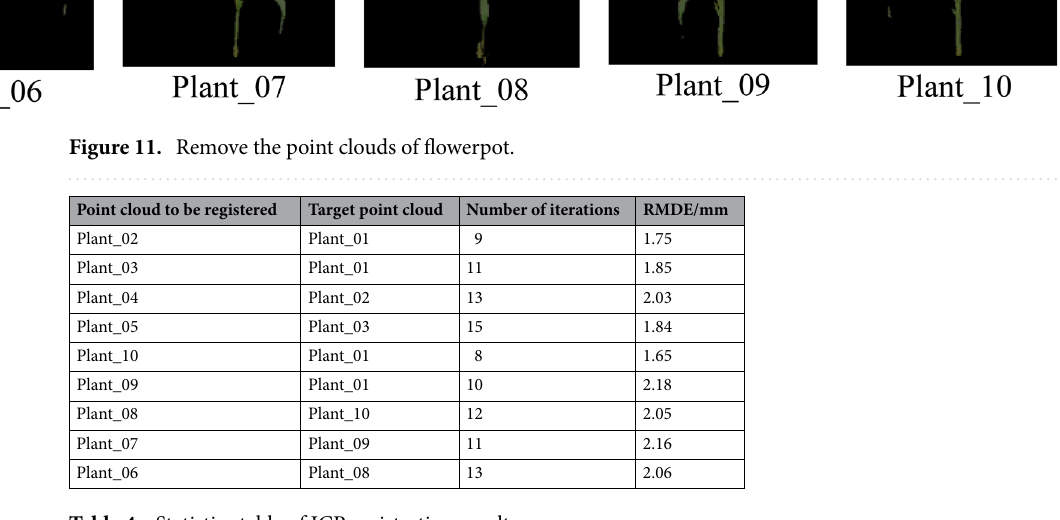
Table 4. Statistics table of ICP registration